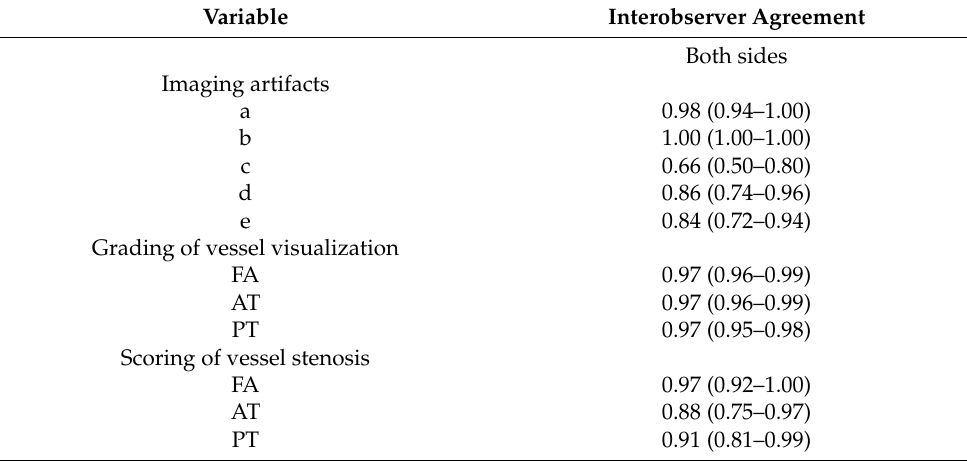
Table 5. Interobserver agreement for the technical and clinical evaluation of Cartesian QISS-MRA. Data are presented as agreement, and 95% confidence intervals are shown in parentheses. Anterior tibial artery is abbreviated to AT, posterior tibial artery to PT, and fibular artery to